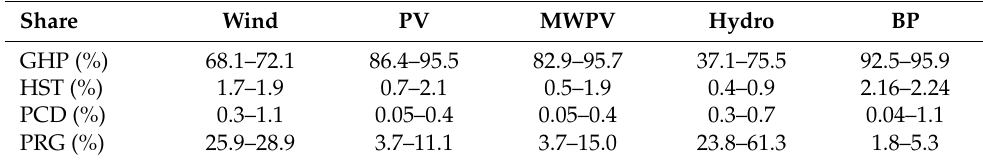
Table 5. Contributions of four stages to life cycle of NOx